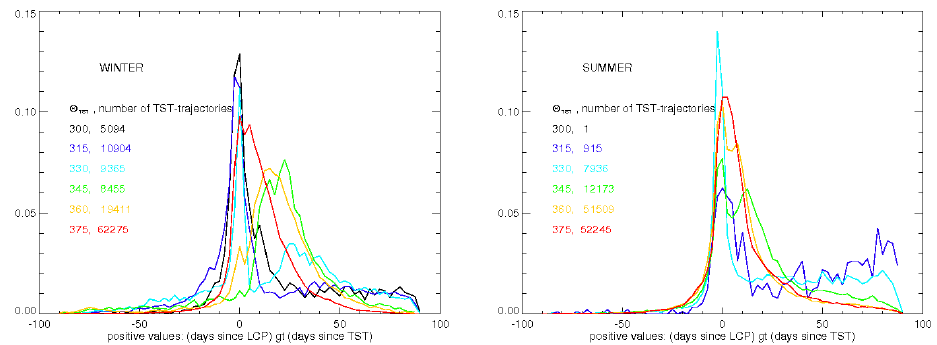
Fig. 7. Normalized probability density functions for the time difference of LCP and TST for TST-trajectories undergoing their TST on different isentropes from 300—375 K in steps of 15 K(colour code) for northern winter (left) and summer (right). Going forward in time positive values indicate that the air parcels encountered their LCP before they crossed the tropopause.